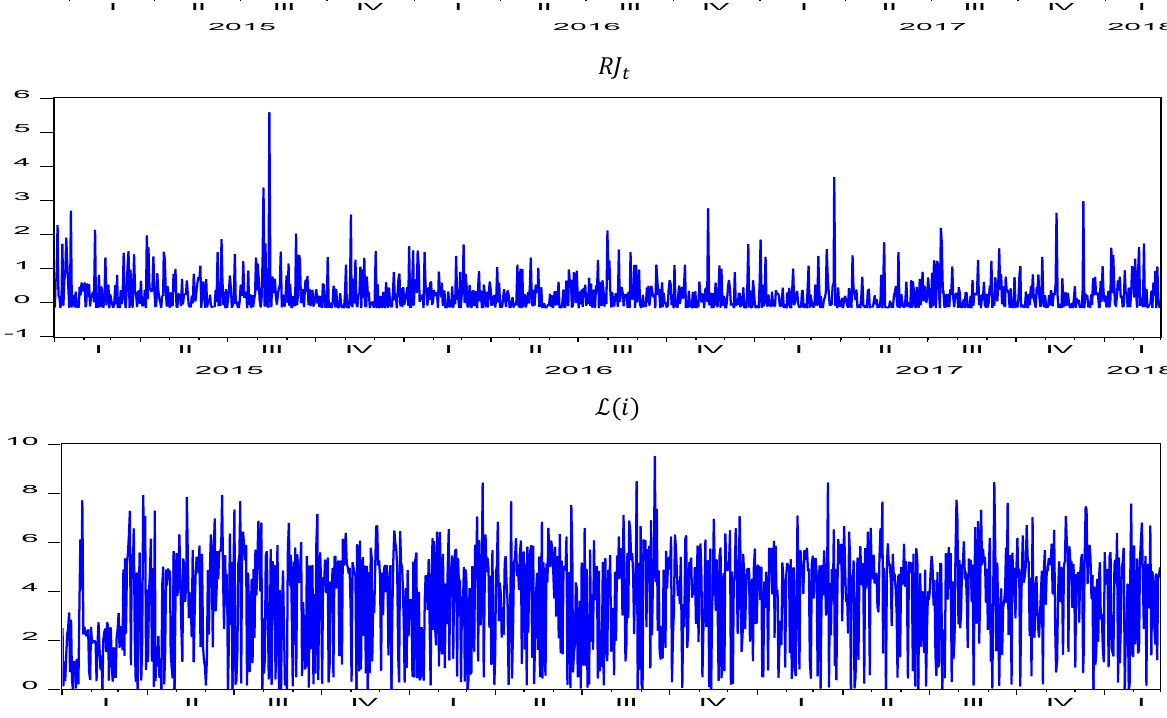
Figure 3. Time series of the Bipower variation, realized volatility, and the relative jump and jump statistic component for Bitcoin prices. The top panel of the figure depicts the BVt (Equation (4)), the second panel plots for respective graphs the daily realized volatility RVt (Equation (3)); the third panel plots the relative jump component RTt (Equation (6)); and the bottom panel depicts the jump statistic L ( i ) (Equation (7)) at significance α = 0.05. Table 1. Descriptive statistics on significant jumps using LM statistics.